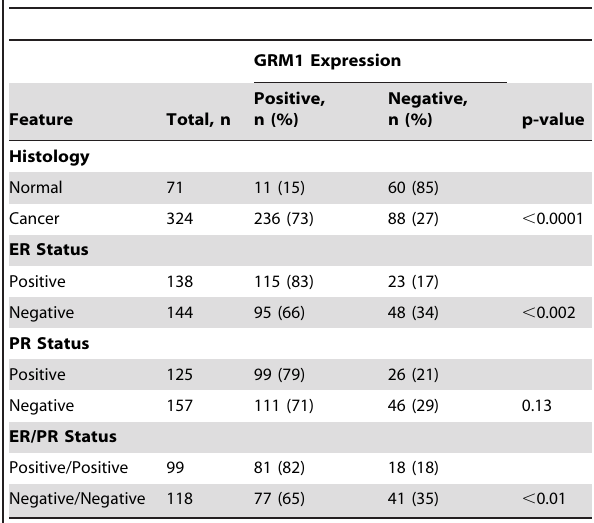
Table 2. Evaluation of immunohistochemical staining of GRM1 in breast cancer and correlation with molecular features from a breast tissue microarray.